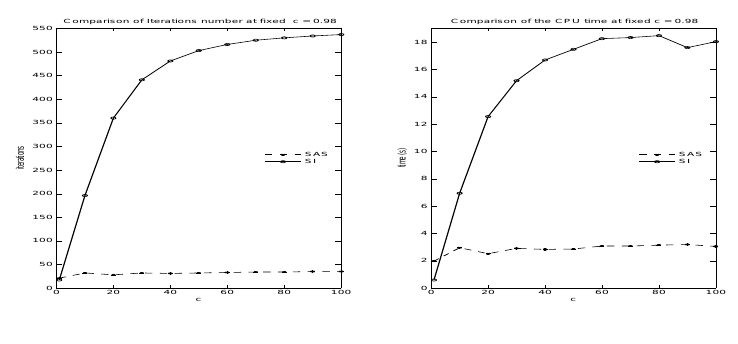
Figure 4. Comparison of the SI and SAS methods in 2D case at fixed c = 0 . 98 ( ǫ = 1 E − 5 ): (left) number of iterations; (right) CPU time.